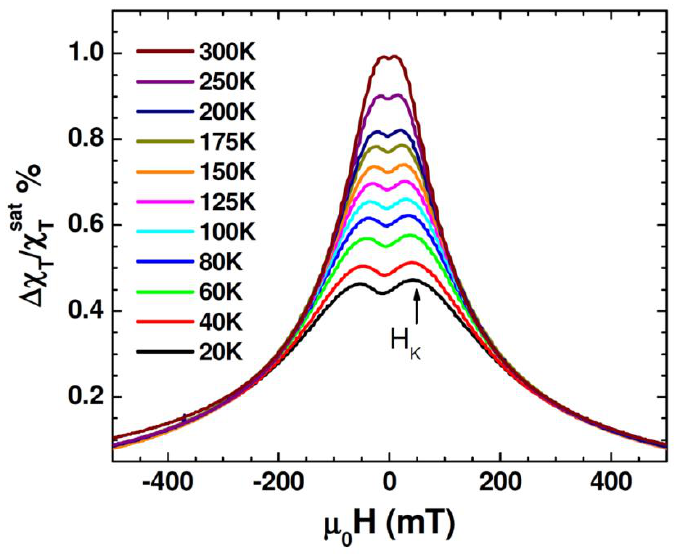
Figure 5. Transverse susceptibility scan taken at different temperatures for Au-Fe O 3 4